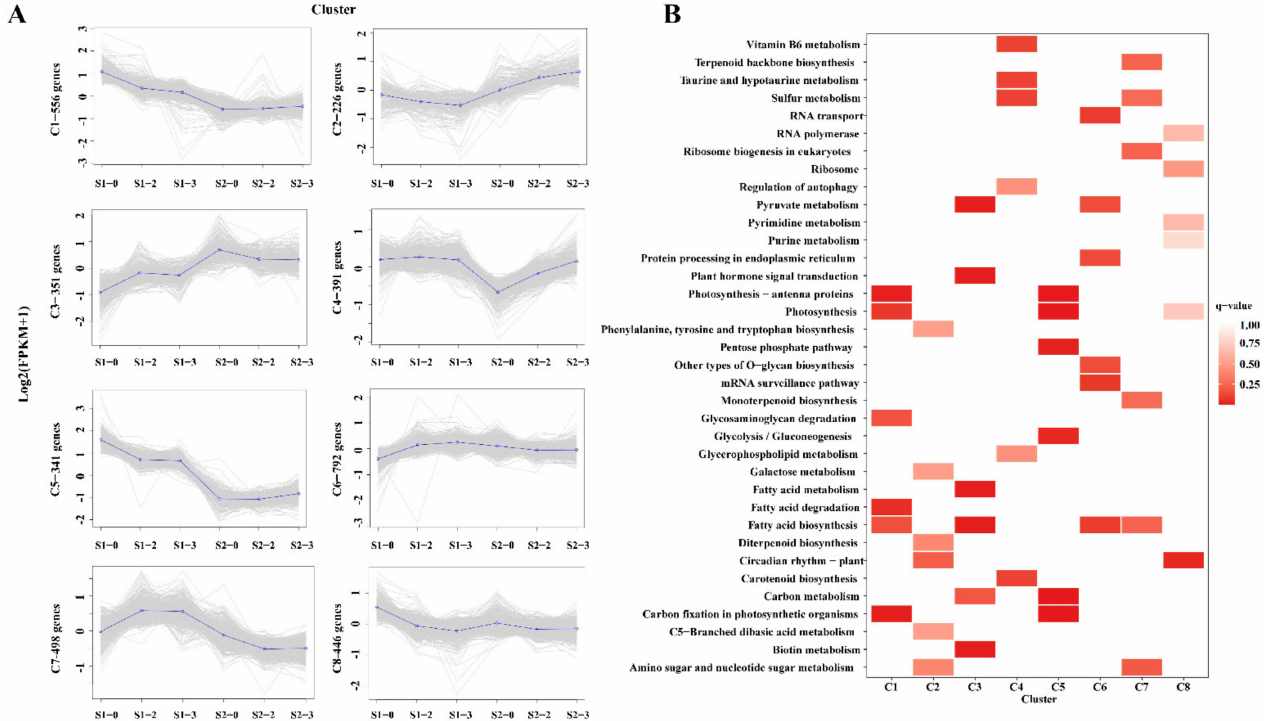
Figure 4. Expression pattern and functional analysis of the DEGs at different nitrogen levels. ( A ) Eight major clusters were identified. The X–axis represents different nitrogen treatments in the S1 and S2 periods. The y–axis represents the value of the relative expression level (log2 (FPKM + 1). ( B ) Functional analysis of the DEGs in S1 and S2